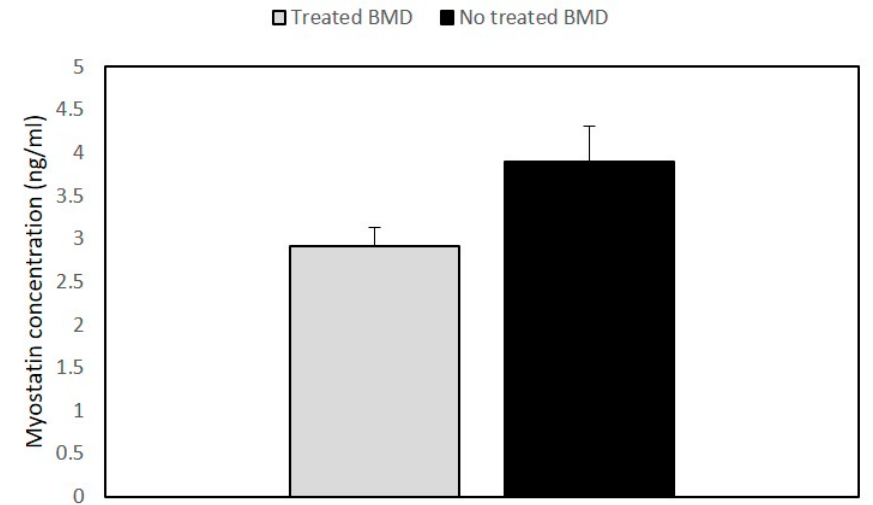
Figure 3. Histogram showing the concentration of myostatin in BMD patients. Quantitative myostatin expression was compared between treated ( n = 2) and untreated BMD ( n = 6) patients using the ELISA test. Data are expressed as mean + standard deviation.